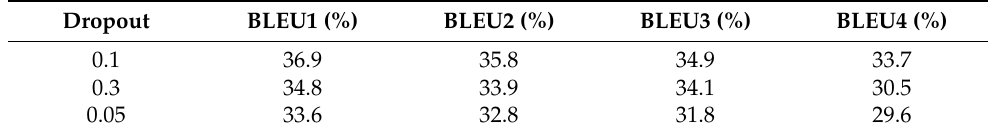
Table 3. Bleu value of ResLSTM-Attention-Seq2seq under different drops.